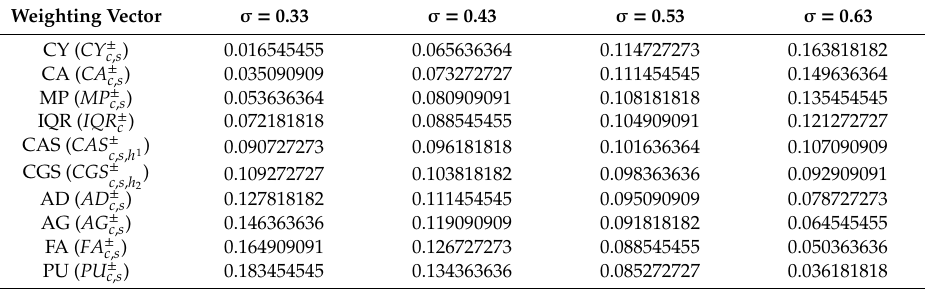
Table 4. The weighting vectors under each σ value.